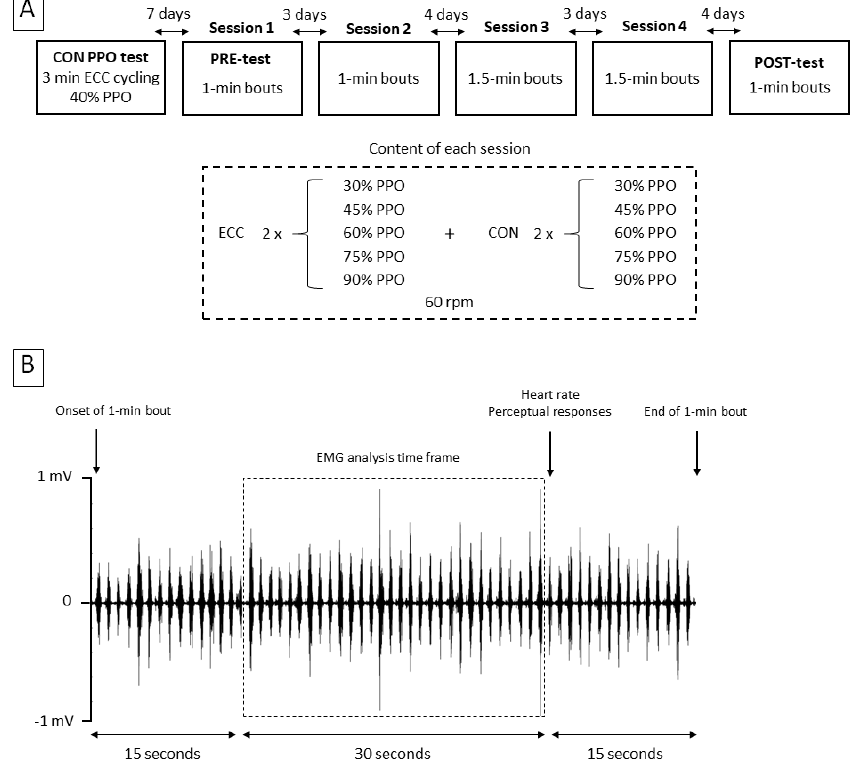
Figure 1. Overview of the protocol. In panel A, each of the six squares represents a session in the laboratory. Measurements were carried out in eccentric and concentric cycling during the first set of the first session (PRE-test) and during the sixth session (POST-test). EMG of the rectus femoris, vastus lateralis, biceps femoris, and soleus muscles, as well as perceptions of effort and of the difficulty to pedal at the instructed cadence (60 rpm), were recorded. Panel B shows an example of a raw and unfiltered EMG signal (at PRE during CON cycling at 60% PPO), with the timing of physiological (EMG and heart rate) and perceptual measurements (perceived effort and difficulty to pedal at the instructed cadence). PPO: Peak power output; CON: concentric cycling; ECC: eccentric cycling.